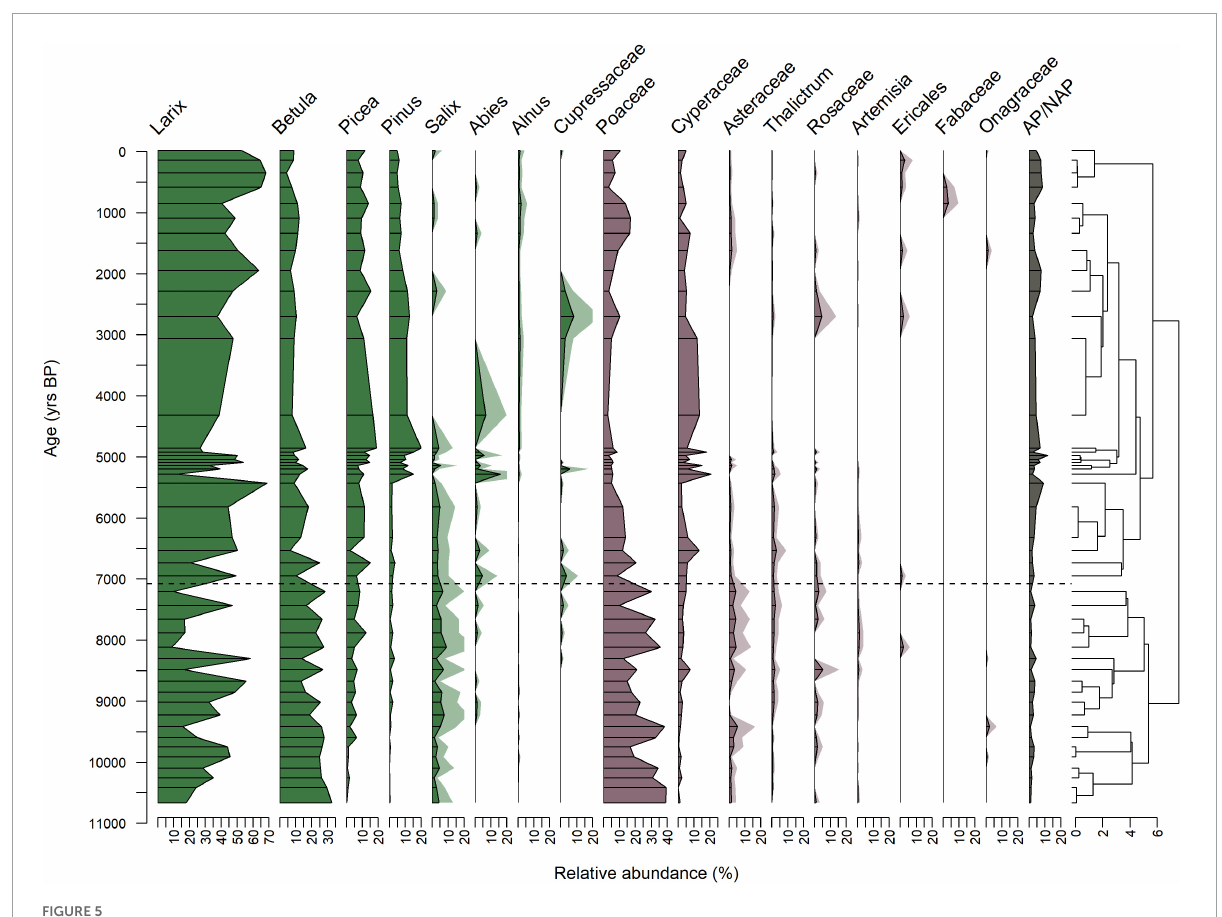
FIGURE5 REVEALS-transformed pollen record, with zone separations from cluster analysis. AP/NAP ratio values without unit. Shaded area represents a visual exaggeration, added to pollen types of lower